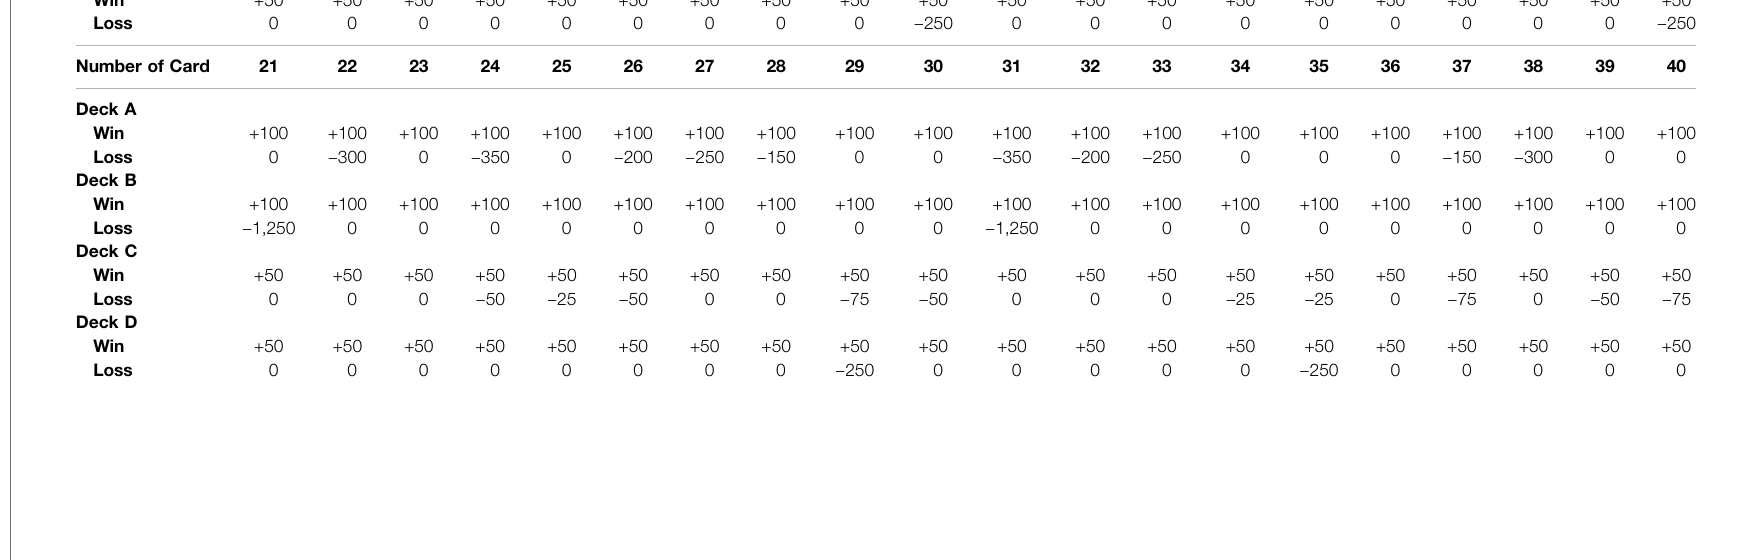
TABLE 1 | Overview of the decks and their win and loss schedule. Values are in $. Number of Card